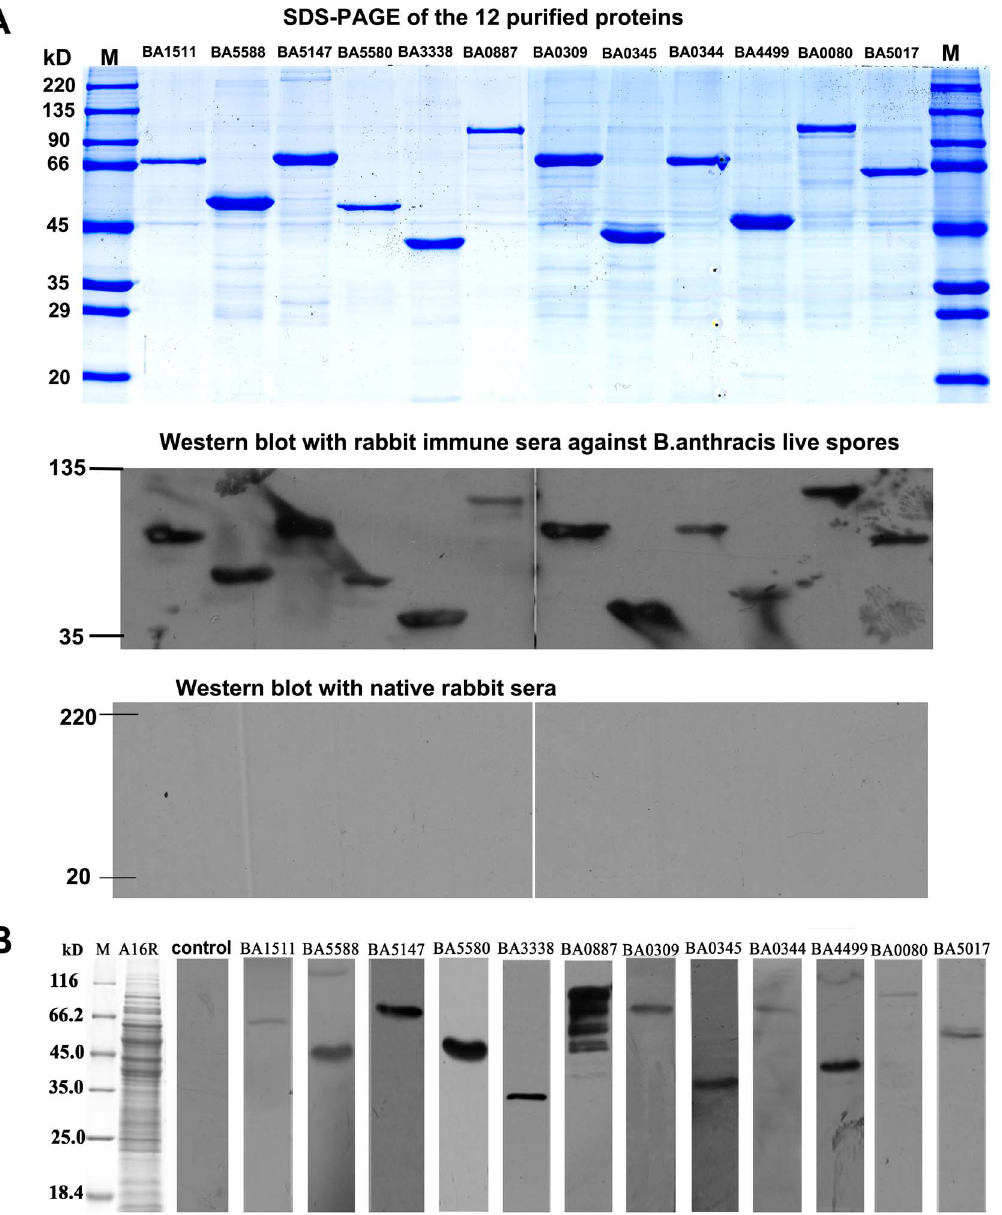
Figure 4. Validation the immunogenicity of the 12 proteins identified by immunoproteomics. (A) The 12 purified proteins were probed with rabbit immune sera against live spores of B.anthracis vaccine strain A16R. The upper panel shows the SDS-PAGE maps of the 12 purified proteins, the middle panel is the western blotting assay with rabbit immune sera against B.anthracis live spores and the lower panel is the western blotting assay with the unimmunized rabbit sera. M:unstained protein molecular weight marker (Cwbio, China). (B) Western blotting assays for A16R whole cell proteins using immune sera from mice vaccinated with the 12 expressed proteins. A16R: whole cell lysate proteins of B. anthracis vaccine strain A16R; control: A16R whole cell proteins were probed with unimmunized mice sera. M: Unstained protein molecular weight marker